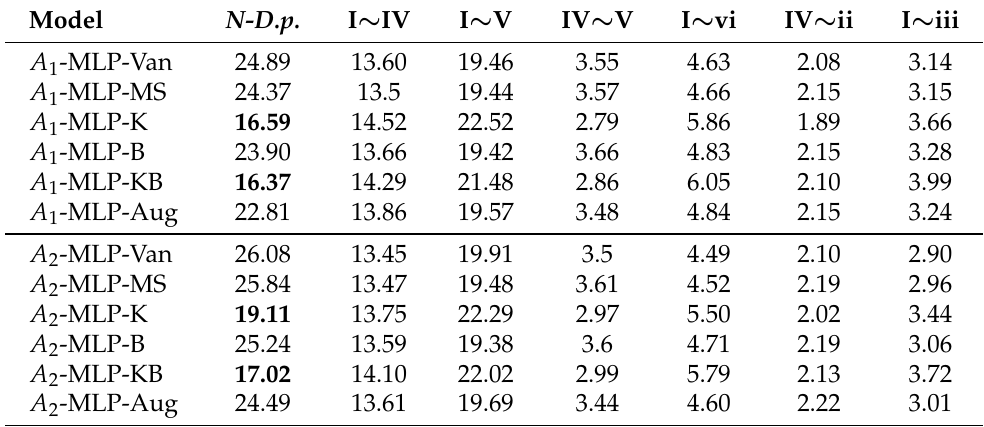
Table A2. Left: percentage of Non-Diatonic prediction ( N-D.p. ) over the classification errors when the target is diatonic, right: errors (>2%) corresponding to degrees substitutions (% of the total number of errors on diatonic